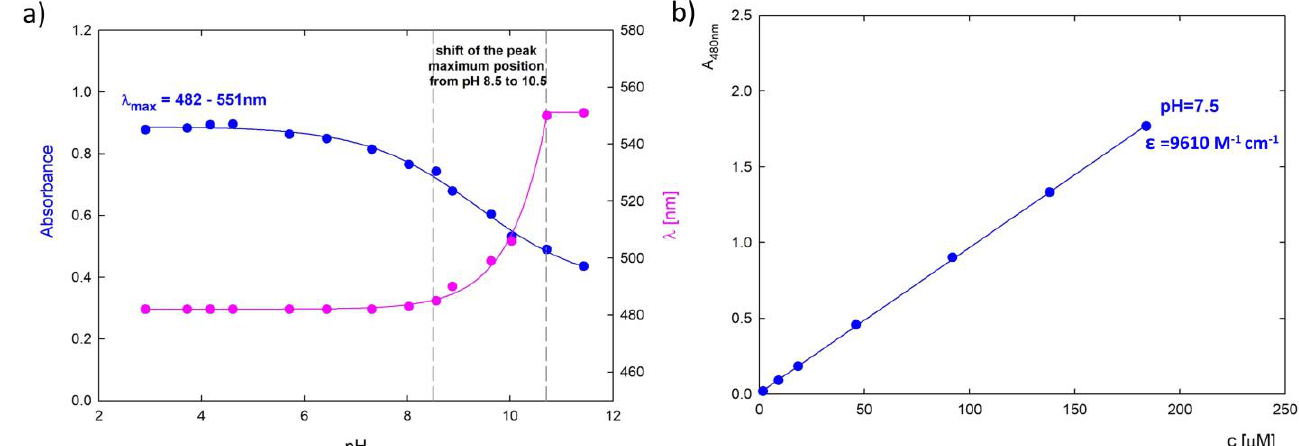
Figure 3. ( a ) A summary of the position of the absorbance maximum of the UV-Vis spectra for DOX (blue curve) and the shift of the absorbance maximum depending on the pH of the solution (pink curve); ( b ) Dependence of absorbance level on DOX concentration at pH 7.50 and wavelength λ = 480 nm.